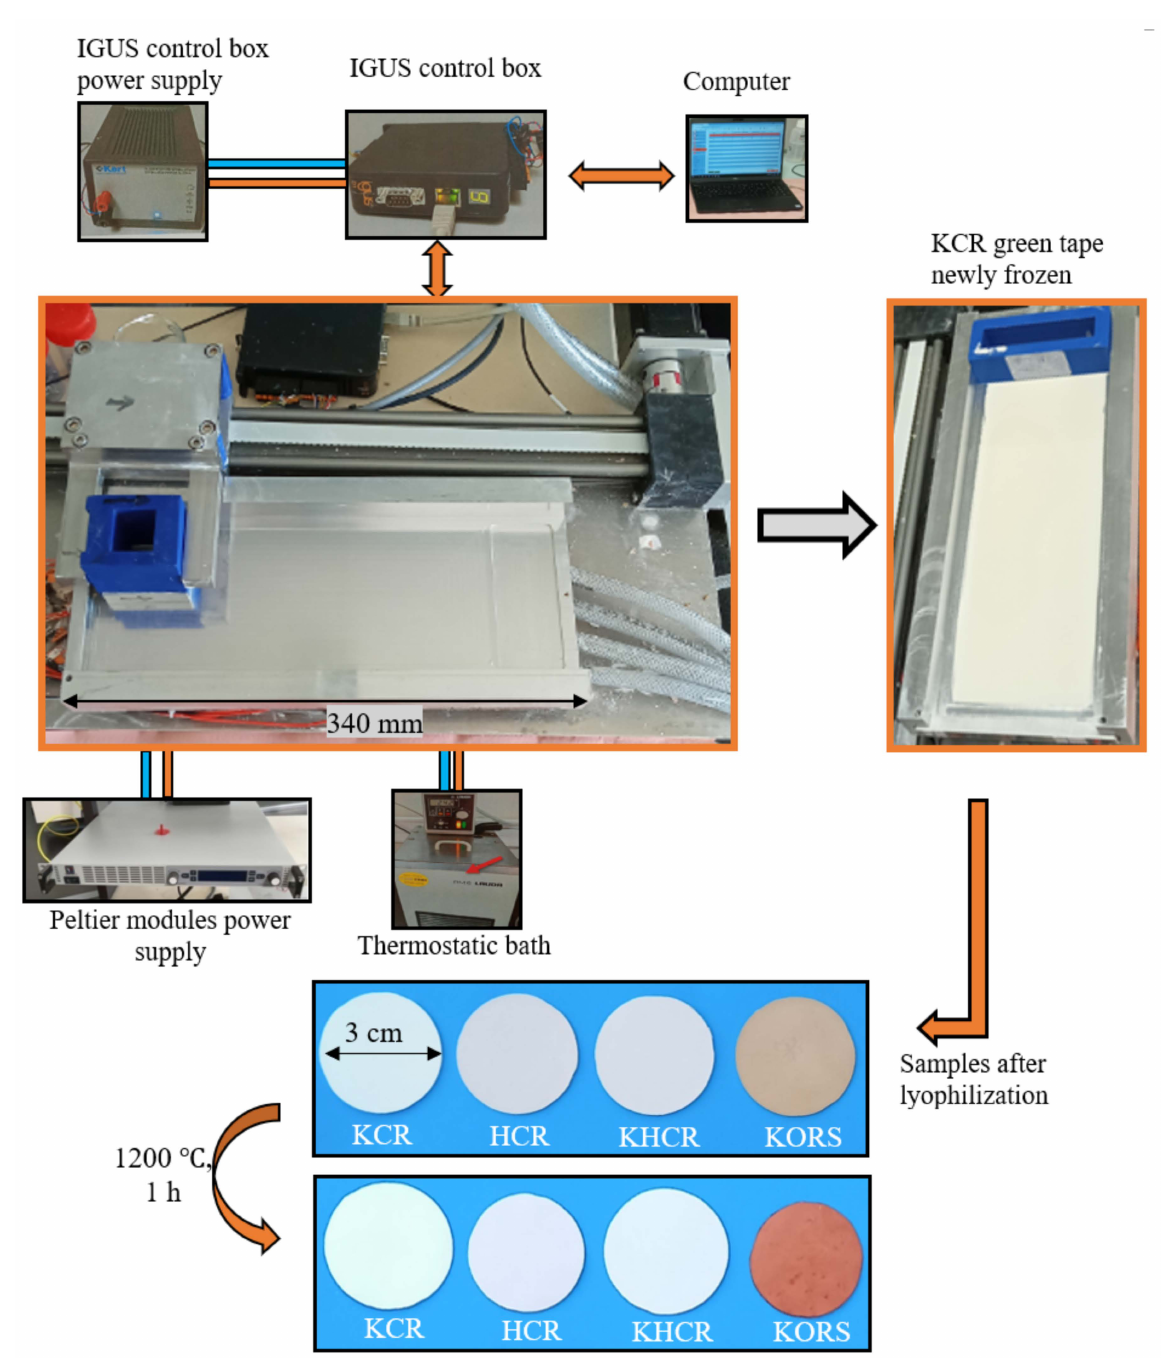
Figure 1. Diagram of freeze-tape-casting device and images of freeze-tape-cast disk samples after freeze-drying and after sintering at 1200 ◦